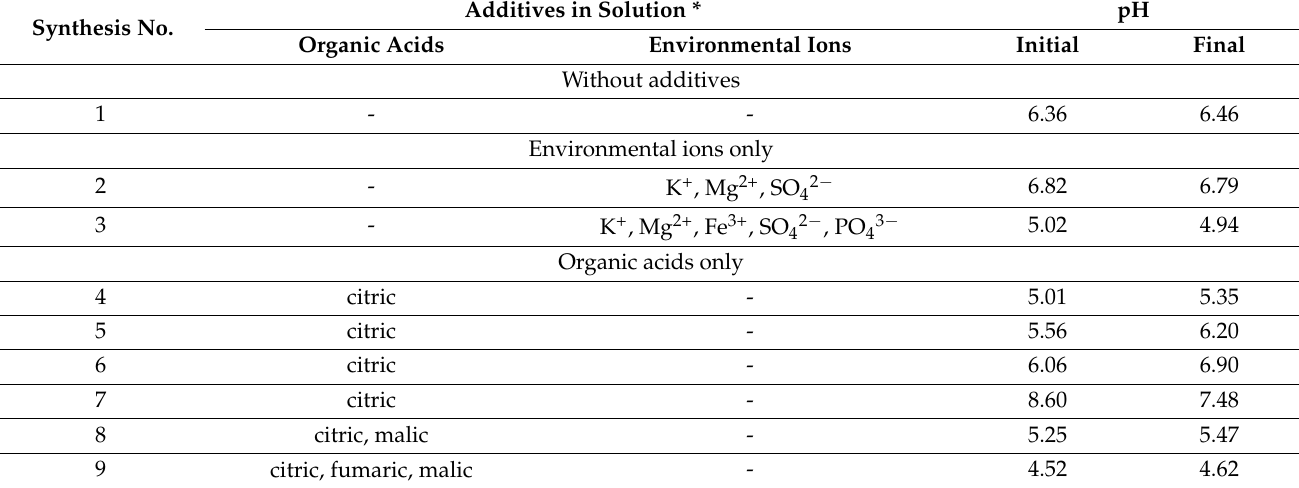
Table A1. Conditions of calcium oxalates syntheses by chemical deposition (temperature 21–25 ◦ C, Ca 2+ /C 2 O 42 − = 4–5). Synthesis